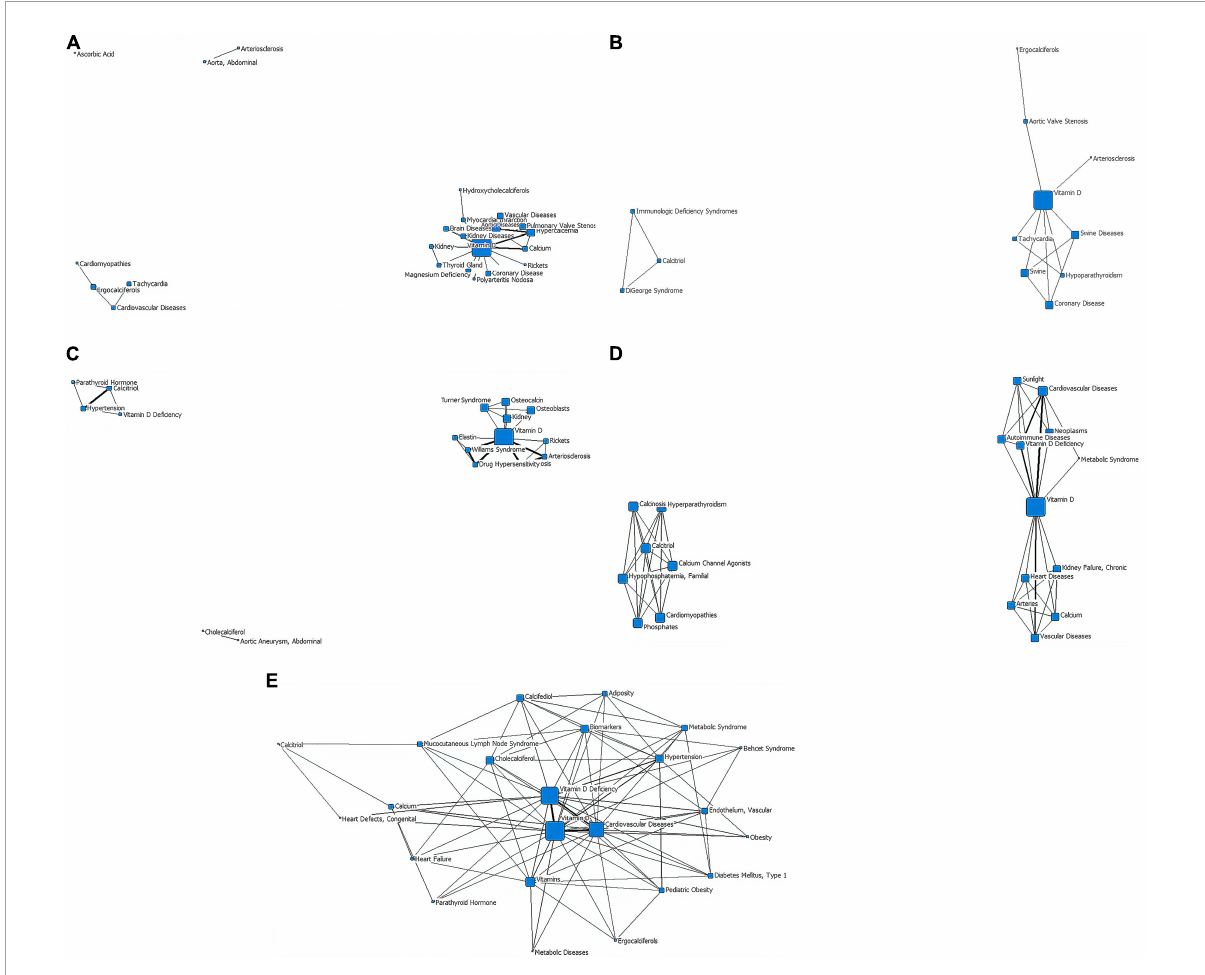
FIGURE4 Social network of core subject terms of “vitamin D AND cardiovascular disease (0-18y)” in the PubMed database before December 2020. (A) 1979. (B) 1980-1989. (C) 1990-1999. (D) 2000-2009. (E)